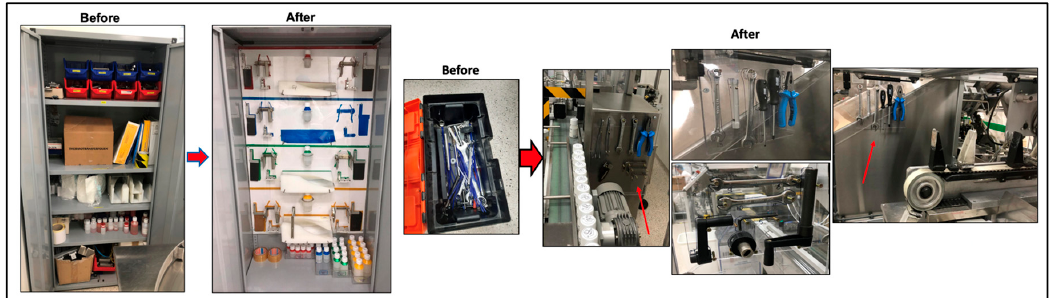
Figure 6. Shadow board.